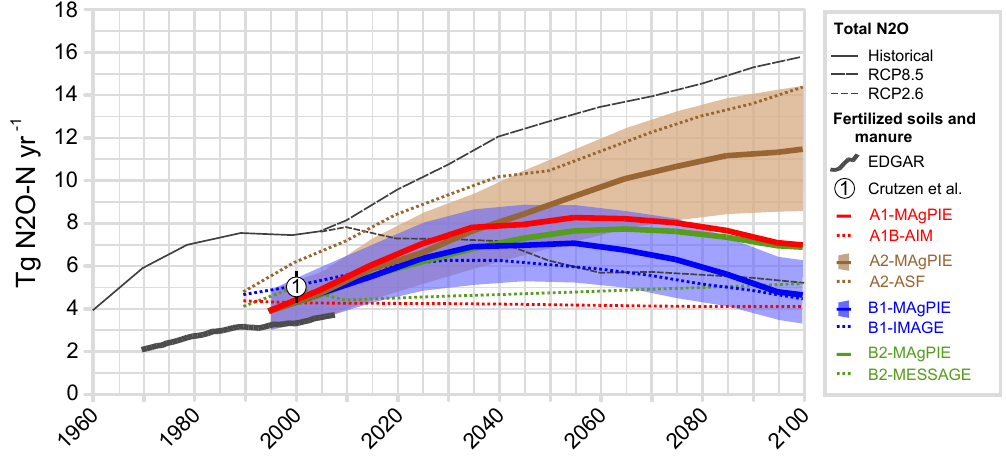
Fig. 4. Total anthropogenic N 2 O emissions: historic emissions, highest and lowest RCP scenarios (Vuuren et al., 2011). N 2 O emissions from soils and manure: historic estimates for 1970–2008 of the EDGAR 4.2 database (EC-JRC/PBL, 2011), a top-down estimate by Crutzen et al. (2008) for the year 2000, the SRES marker scenarios (Nakicenovic et al., 2000) for 1990–2100 and our scenarios for the SRES storylines for 1995–2095. The shaded areas represent a 90% probability range in respect to the uncertainty of emission parameters of our A2 and B1 scenarios. Our A1 and B2 scenarios have a similar relative uncertainty